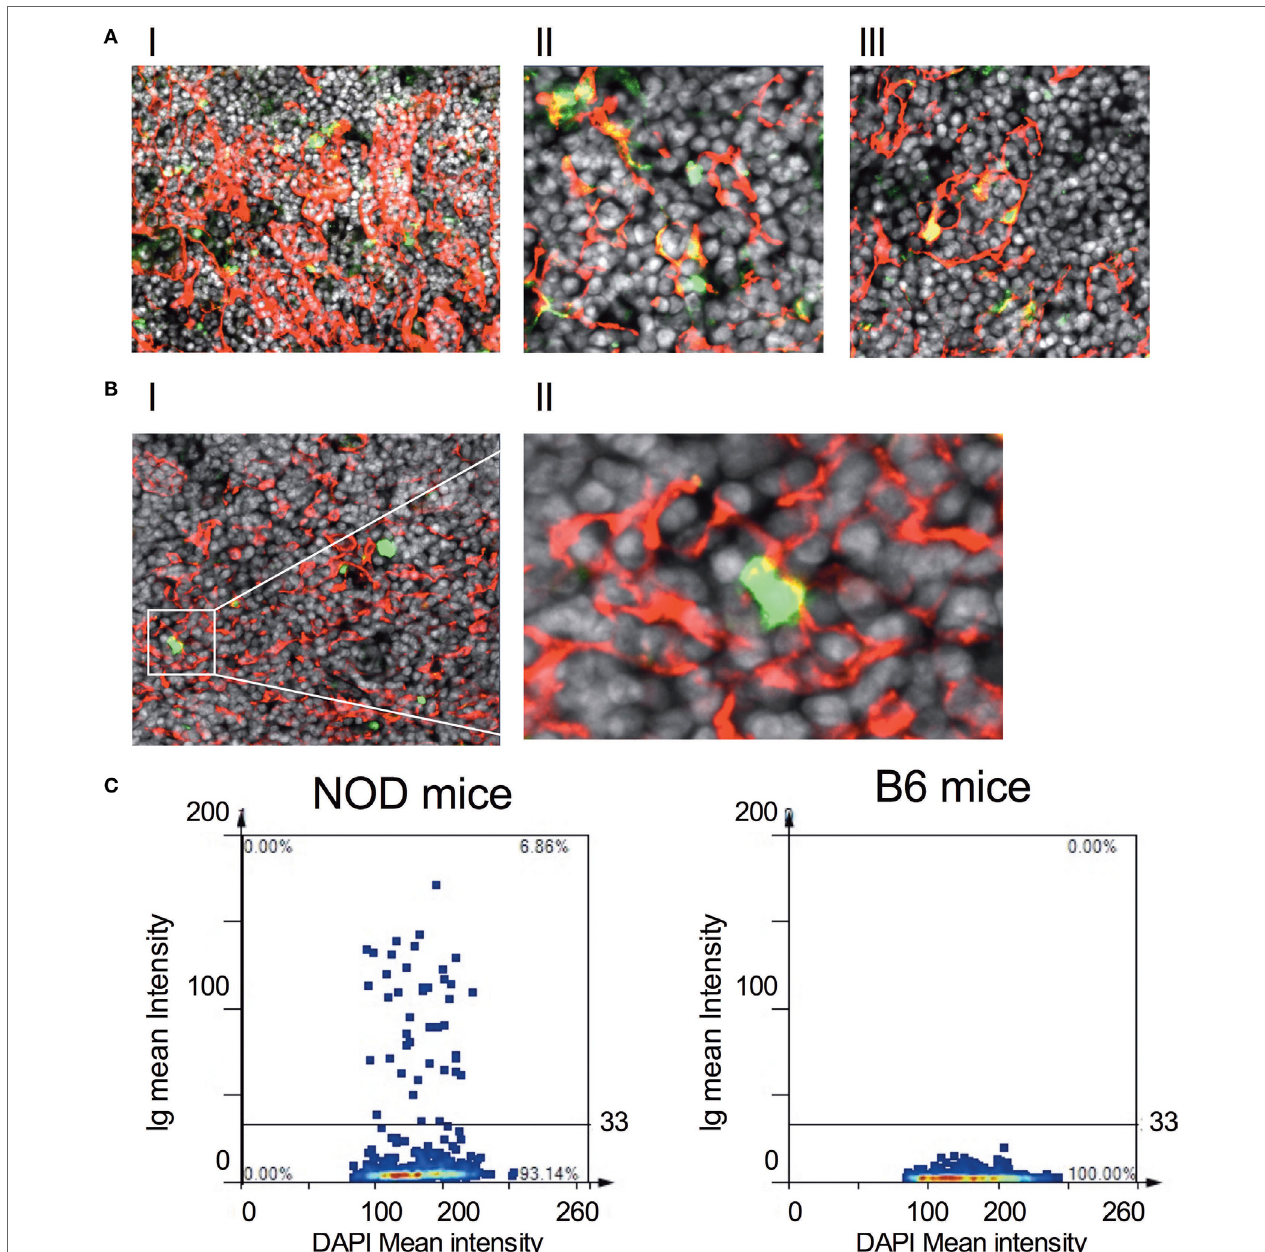
FigUre 5 | IgGs bind to thymic stromal components in non-obese diabetic (NOD) mice. (a,B) Representative confocal immunofluorescence microscopy images of thymi sections of NOD [ (a) , I–III] and B6 mice [ (B) , I–II] examined for cytokeratin V (red), murine IgG (green), and the DNA-intercalating dye DAPI (white). A total of six 11-week-old NOD mice and five 11-week-old B6 mice, two sections per mouse were examined. [ (a) , I–II] is derived from different NOD mice. The confocal fluorescent image in AI was obtained with a Plan-Apochromat 20 × objective to give a broader view of the extent of immunoglobulin bound to thymic stroma, arrows indicating some of the cells co-positive for cytokeratin V and mouse IgG. The confocal fluorescent images in AII and AIII were obtained with a Plan-Apochromat 63 × objective. For panel (B) , the confocal fluorescent image was obtained using a Plan-Apochromat 20 × objective. (c) Quantification of murine Ig-bound to stromal cells of age-matched 11-week-old, female NOD or B6 mice. Confocal immunofluorescence microscopy images were subjected to StrataQuest V64 analysis, a total of 2–3 × 10 4 DAPI + cells/mm 2 were counted, and the mean fluorescence intensity of DAPI + cells versus mean fluorescence intensity of anti-Ig is presented as a scattergram. The data shown are representative of two independent mice examined giving similar